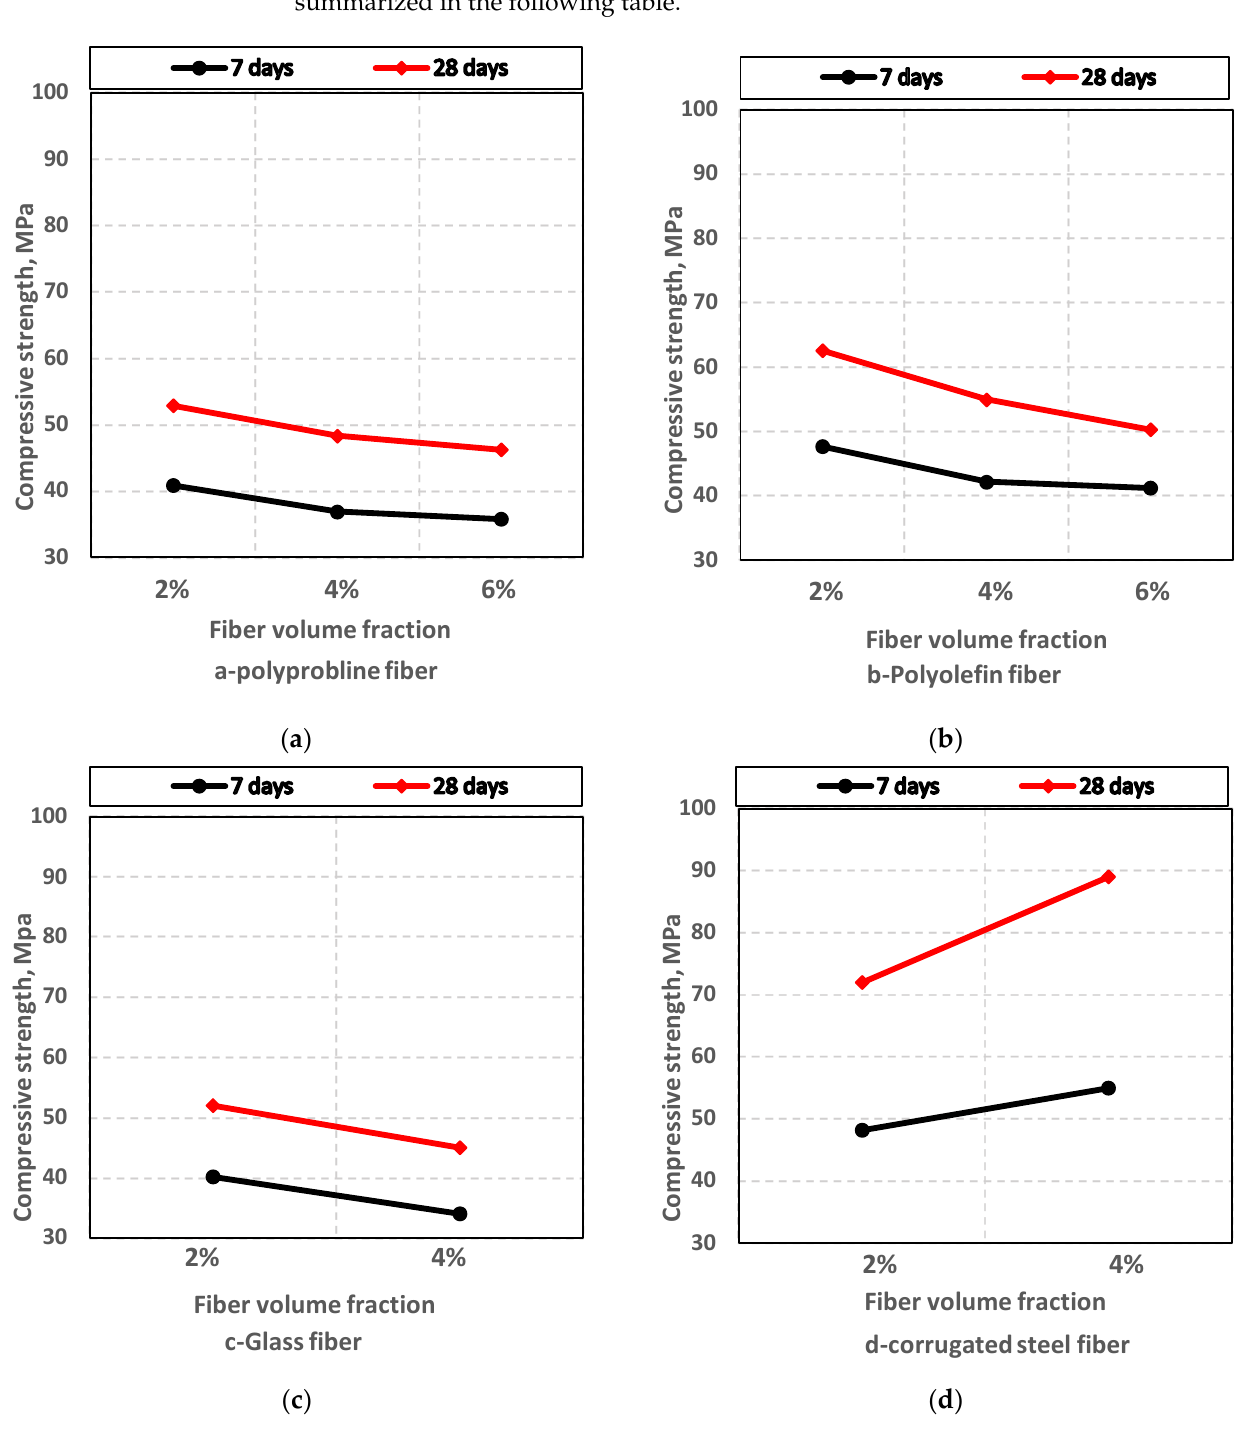
Figure 3. Compressive strength of FRC and ECC; ( a ) PP, ( b ) PO, ( c ) G.F, ( d ) C.S.F.